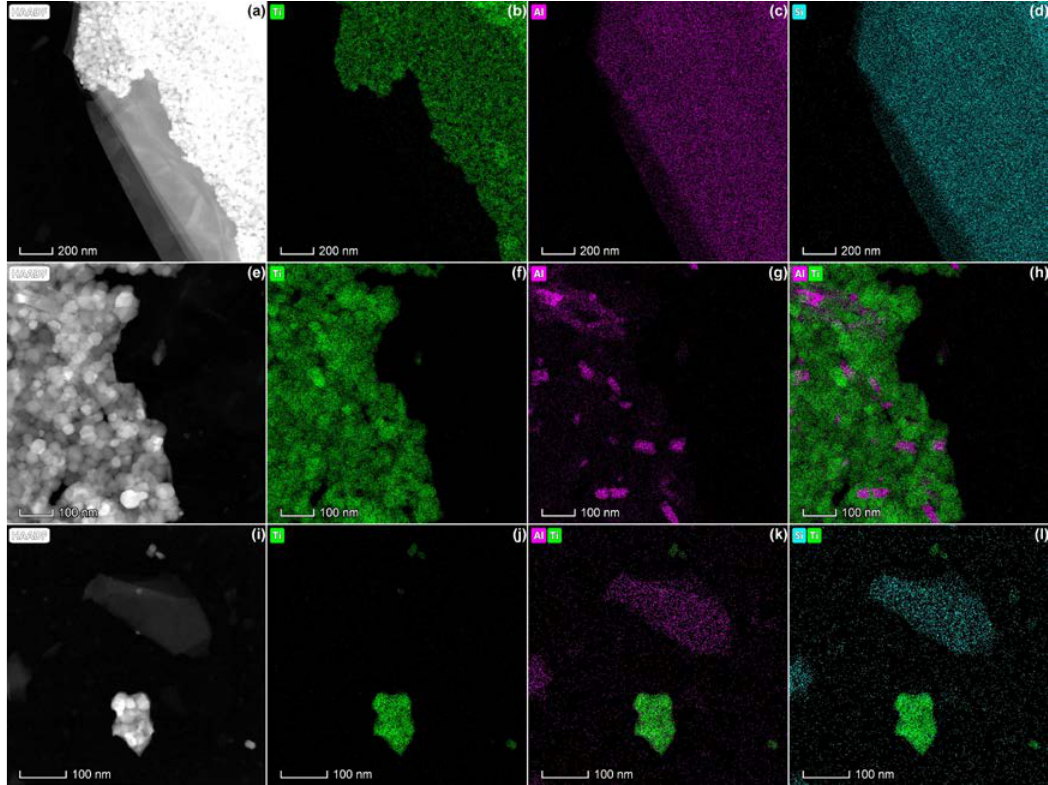
Figure 4. HAADF-STEM images (a,e,i) and corresponding spectral images of Ti (green), Al (pink), and Si (blue) obtained by EDX of pearlescent pigments, showing ( a – d ) aggregated TiO 2 particles on top of mica, ( e – h ) a TiO 2 aggregate containing small parts of mica, and ( i – l ) separate TiO 2 aggregates and a mica flake.